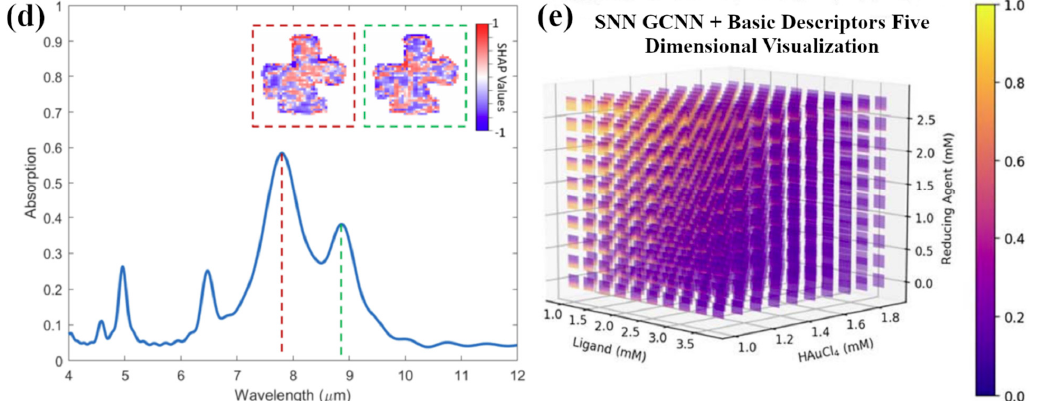
Figure 7. ( a ) The ML inverse design framework established for structural colour, where SL and RL are used in tandem to predict structural geometries for desired colour properties. Adapted with permission from Ref. [131] . Copyright Royal Society of Chemistry (2019). ( b ) Deep Q-Learning framework used for designing optimized optical thin films for a wavelength selective solar absorber. Adapted with permission from Ref. [132] under terms of the CC-BY 4.0 license. Adapted with permission from Ref. [132] under terms of the CC-BY 4.0 license. Copyright Nature (2020). ( c ) Given a desired reflection spectrum in the top graph of Figure 7c, a framework developed with SSL can carry out inverse design of different metamaterial structures whose reflection spectra match the one desired with high accuracy, as seen in the bottom 2 graphs of Figure 7c. Adapted with permission from Ref. [99]. Copyright Wiley-VCH (2019). ( d ) The application of SHAP in identifying exactly which parts of the freeform structure contribute positively (in blue pixels) and negatively (in red pixels) to the specified resonances. Adapted with permission from Ref. [137]. Copyright American Chemical Society (2020). ( e ) A 5-dimensional visualization of the probabilities in successfully synthesizing monodisperse Au nanoclusters, where for fixed ligand, solvent, and reducing agent, their concentrations can be changed and for each combination of these 3 parameters, a temperature vs. pH 2-dimensional map can be generated. Adapted with permission from Ref. [142] under terms of the CC-BY 4.0 license. Copyright Wiley-VCH